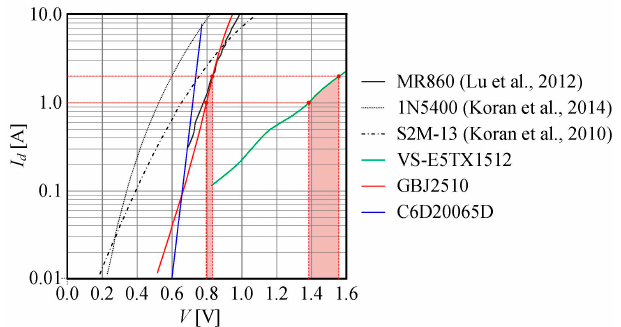
Figure 8. Comparison of the I d –V properties of the different diodes [1,13,14].